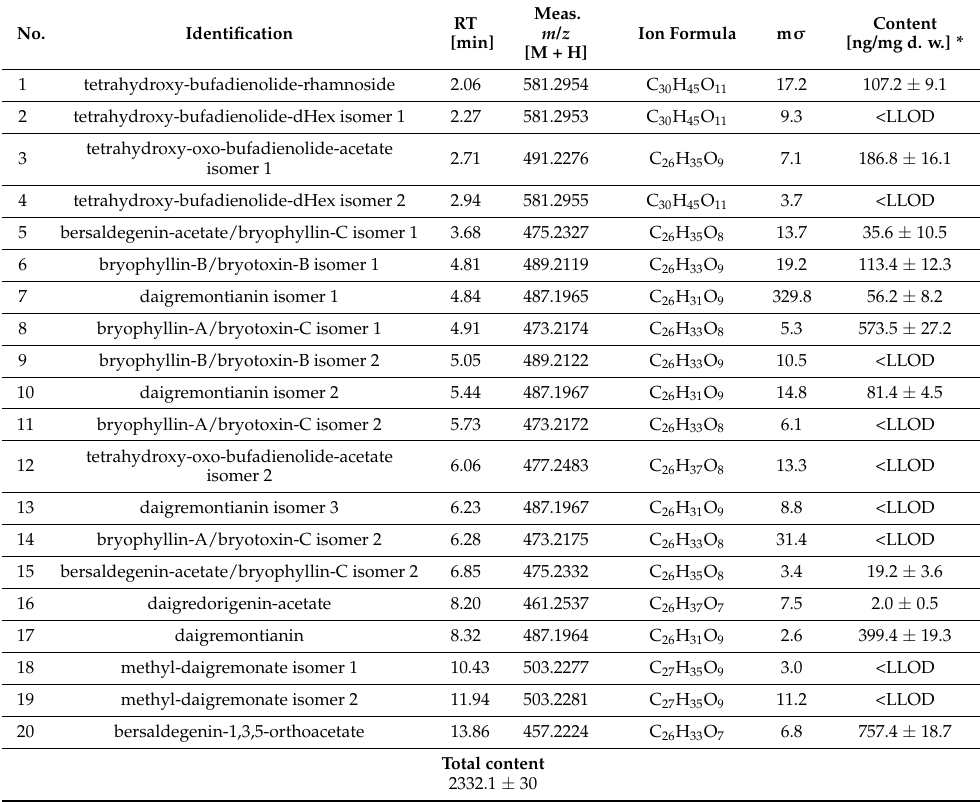
Table 1. Identification and content of bufadienolides in Kalanchoe daigremontiana water extract using UHPLC-QTOF-MS